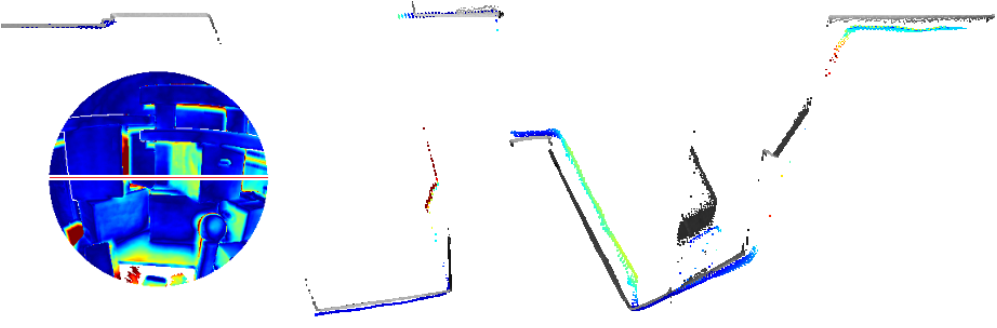
Figure 22. Cross section from Figure 11a corresponding to the red line on white background shown in the small range image in this figure. The large deviation of the range measurements on the left side of the right box from the ground truth (visualized in gray-scale) are possibly caused by multi-path